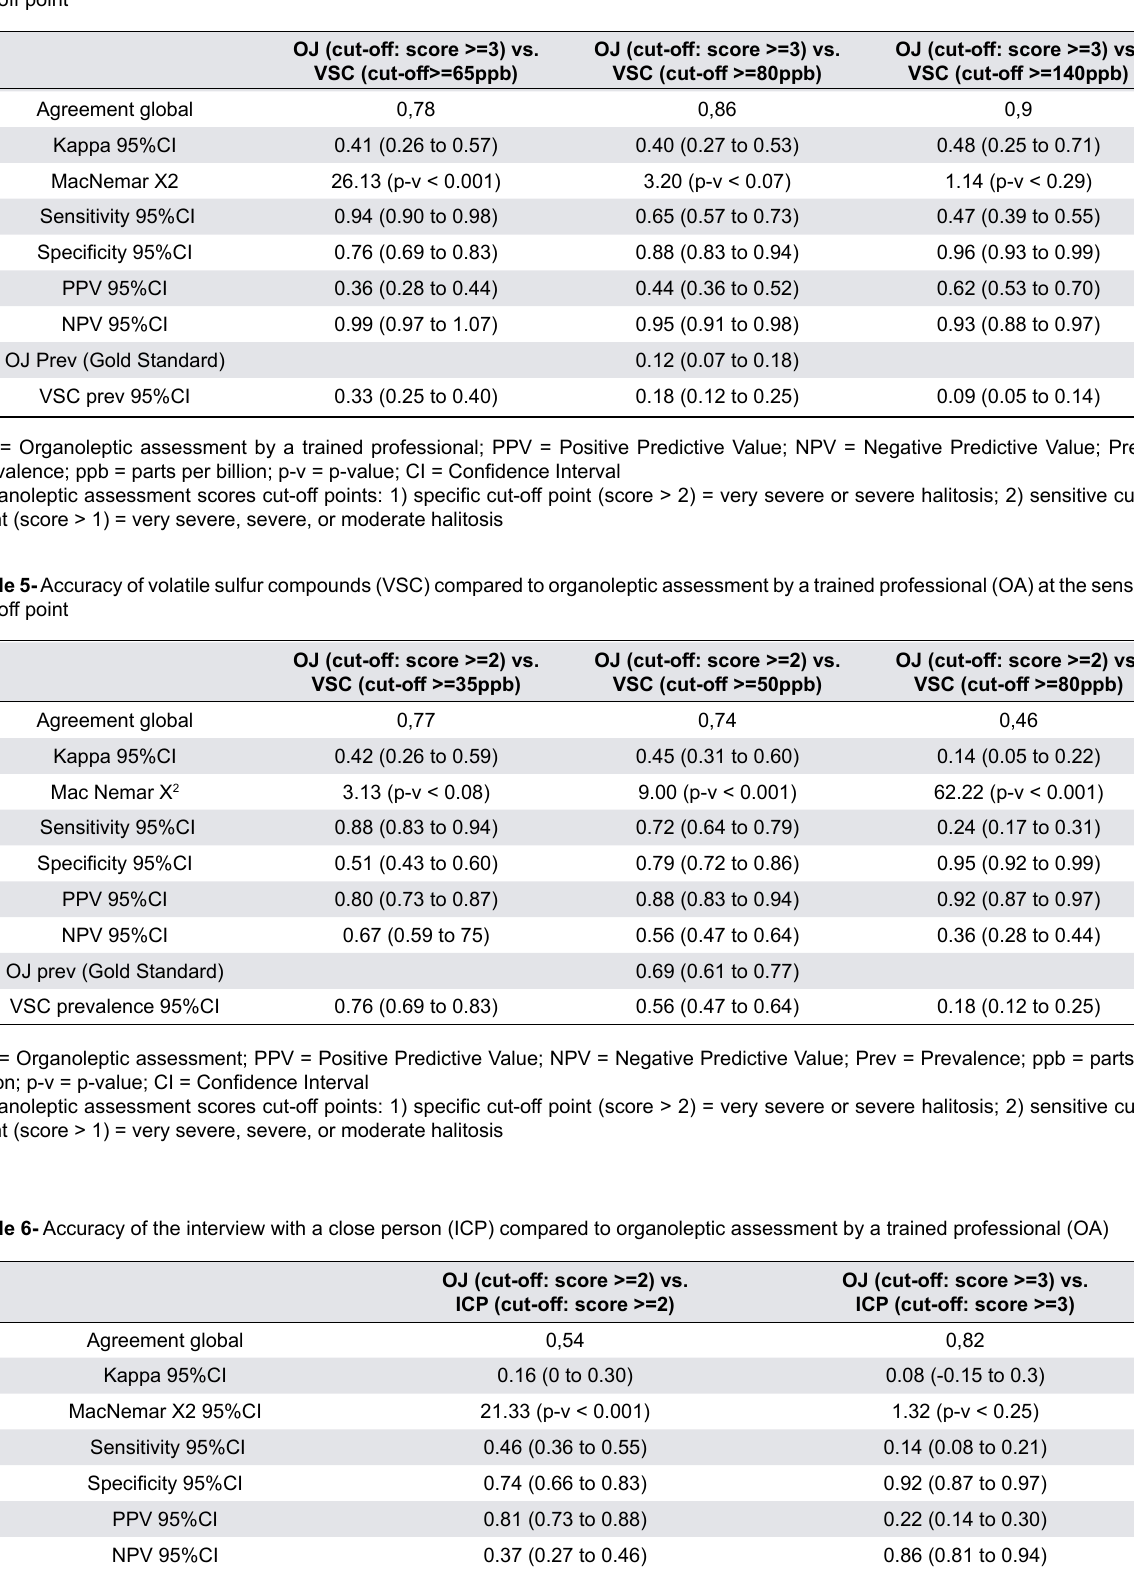
Table 4- Accuracy of volatile sulfur compounds (VSC) compared to organoleptic assessment by a trained professional (OA) at the specific cut-off point